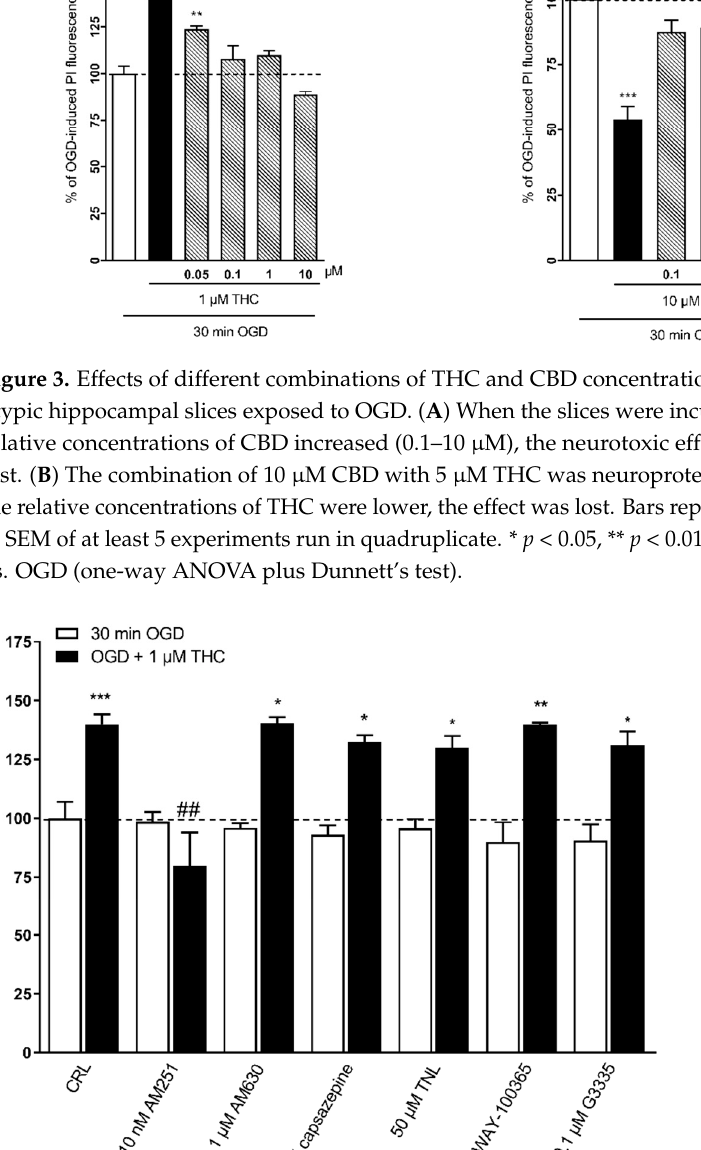
Figure 4. The effects of THC and CBD on OGD toxicity in rat organotypic hippocampal slices de- pend on different receptors. ( A ): The neurotoxic effects of 1 µM THC on CA1 were completely pre- vented only by co-incubation with the CB1 receptor antagonists AM251. ( B ): On the other hand, the neuroprotective effect of 10 µM of CBD was completely prevented by co-incubation with the TRPV2 antagonist tranilast (TNL), or 5HTA1 antagonist WAY-100635, or PPAR γ antagonist G3335, but not by the CB1 receptor antagonists AM251, the CB2 antagonist AM630, and the TRPV1 antagonist capsazepine. Bars represent the mean ± SEM of at least 5 experiments run in quadruplicate. * p < 0.05, ** p < 0.01 and *** p < 0.001 vs. OGD; ## < 0.01vs. OGD + THC for (A); ## < 0.01vs. OGD + CBD and ### < 0.001vs. OGD + CBD for (B) (one-way ANOVA plus Tukey’s w- test). 2.2. CBD Rescues Neuronal Damage in OGD-Treated Slices We assessed the effects of CBD and THC on CA1 pyramidal cell viability using im- munostaining for NeuN on organotypic slices harvested 24 h after 30 min OGD followed by immunofluorescence and confocal microscopy. The qualitative analysis of NeuN-positive neurons in organotypic hippocampal slices (Figure 5B,B1,B2) shows that OGD caused complex morphological modifications in many